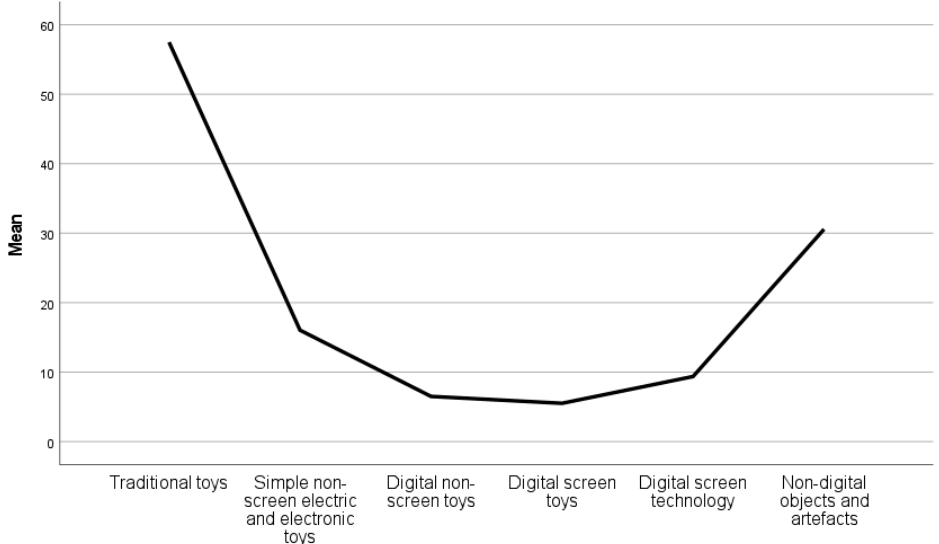
Figure 5. Parents’ estimation of playtime with traditional and digital toys. The use of traditional toys does not vary much with age. Non-digital objects and artefacts are highest at two (38.69%) and three (35.25%), while at the age of five, they reduce to 25.39%.